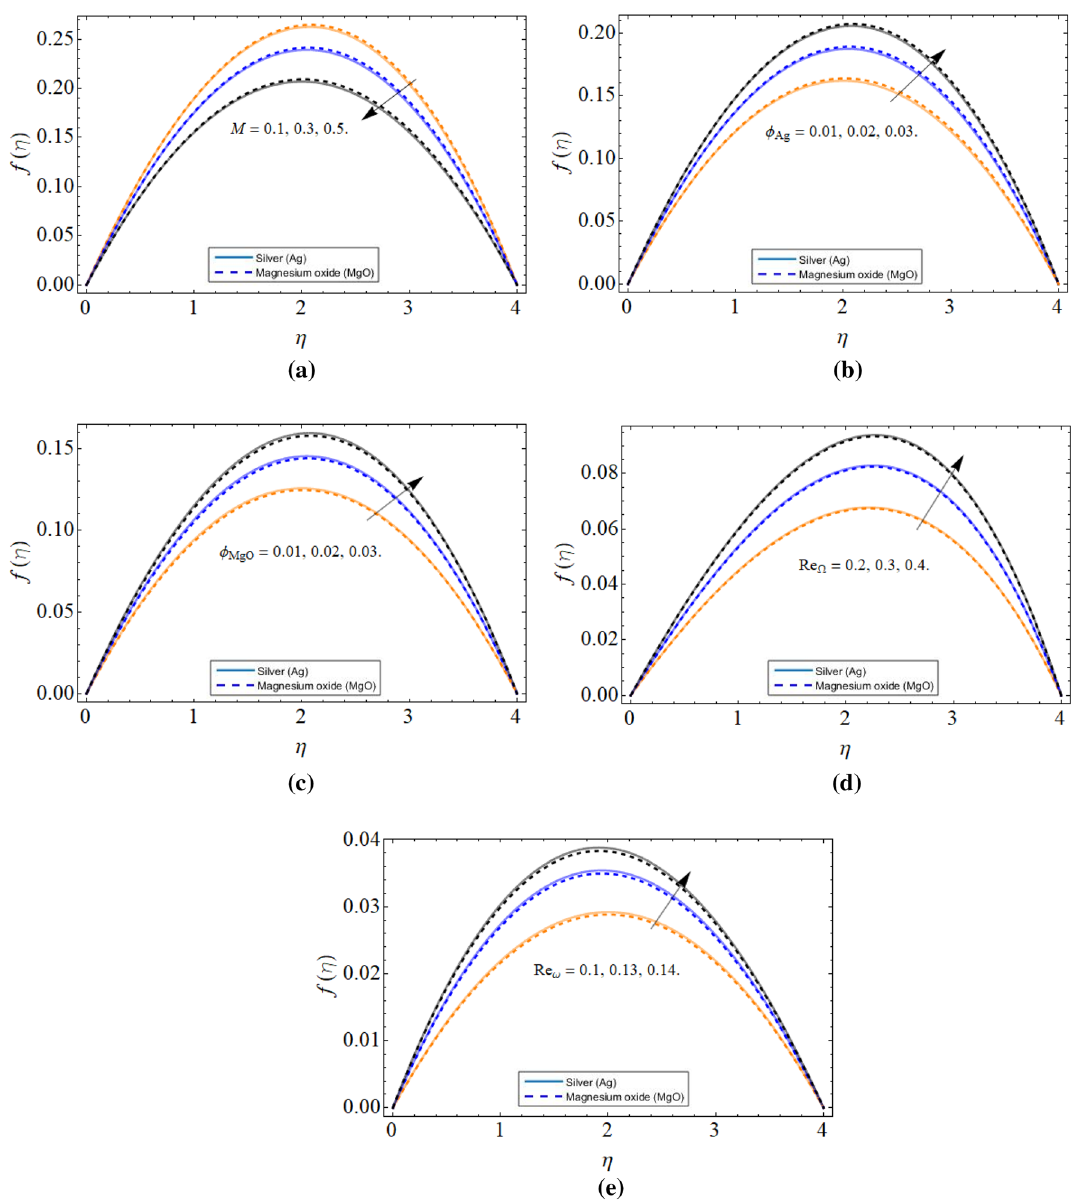
Figure 2. The behavior of axial velocity profile f (η) versus ( a ) magnetic field M ( b ) volume friction of silver φ Ag ( c ) volume friction of magnesium oxide φ MgO ( d ) cone angular velocity Re (cid:31) ( e ) disk angular velocity Re ω Axial velocity profile. Figure 2a–e revealed the behavior of axial velocity f (η) profile versus magnetic field M , volume friction of silver φ Ag , volume friction of magnesium oxide φ MgO , cone angular velocity Re (cid:31) and disk angular velocity Re ω respectively. The resistive force generated due to the consequences of the magnetic field declines the axial velocity as shown in Fig. 2a. Figure 2b,c manifested that the velocity profile enhances with the increment of both silver Ag and magnesium oxide MgO nanomaterials because the specific heat capacity of MgO and Ag nanoparticles is much less than water, that’s why the rising thermal energy inside the hybrid